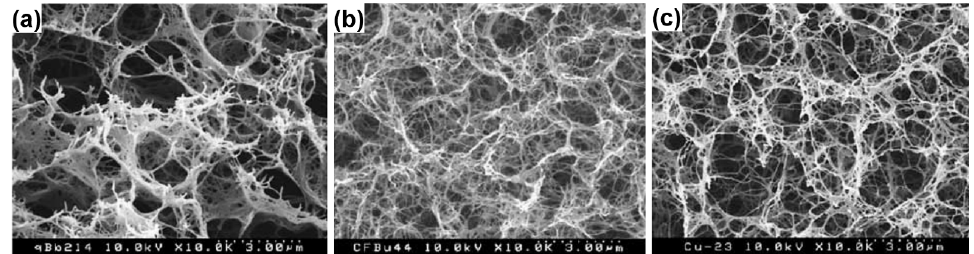
Figure 3. SEM images of 1% cellulose aerogel by ( a ) regular freeze drying; ( b ) solvent exchange drying; and ( c ) rapid freeze drying. Reproduced with permission of [90] (Copyright Elsevier 2004). drying; and ( c ) rapid freeze drying. Reproduced with permission of Ref. [90] (Copyright Elsevier